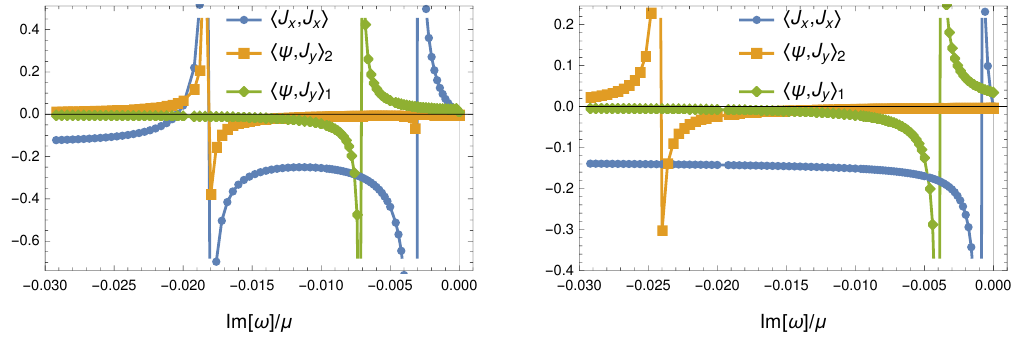
Figure 10. The profiles of the 2-point correlation function at imaginary frequency, used to detect the positions of quasinormal modes shown on figure 3. Right panel. Above T pled and every single peak appears in its own channel. Left panel. Below T nel, dominated by the momentum relaxation mode, overlaps with shifts of spontaneous structure described by the damped Goldstone mode, therefore the corresponding QNMs appear in both chan- nels. The data is for A = 0 . 6 , the temperatures are T/µ = 0 . 1509 and T/µ = 0 . 1519 ,